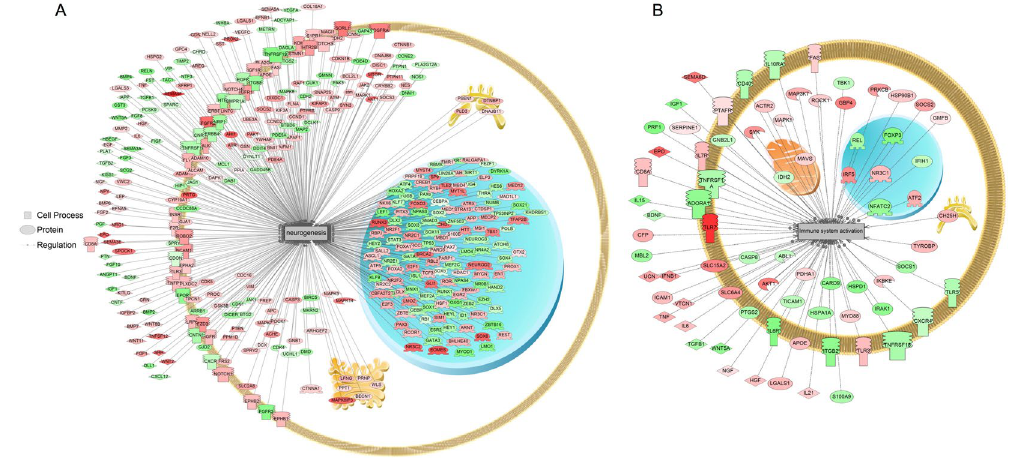
Figure 4. Subnetwork enrichment analysis (SNEA) indicated that genes involved in ( A ) neurogenesis and ( B ) immune system activation were significantly enriched in Carassius auratus RGC cultures following 24 h exposure to 1000 nM SNa treatment (P < 0.05). Red indicates that gene expression was increased and green indicates that gene expression was decreased. All abbreviations are provided in Supplemental File